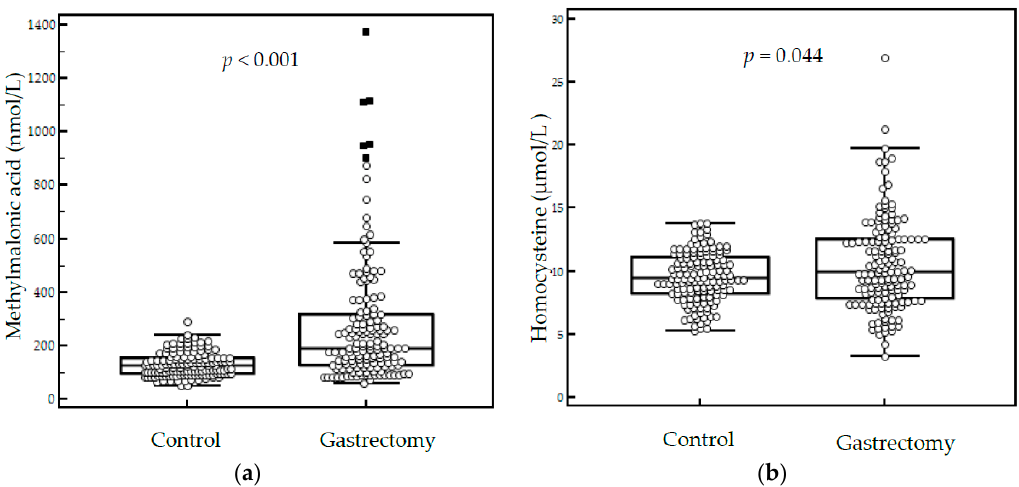
Figure 1. Serum methylmalonic acid ( a ) and homocysteine levels ( b ) in the control group ( n = 142) and Figure 1. ( a ) Serum methylmalonic acid and ( b ) homocysteine levels in the control group ( n = 142) gastrectomy patient group ( n = 151). and gastrectomy patient group ( n = 151).